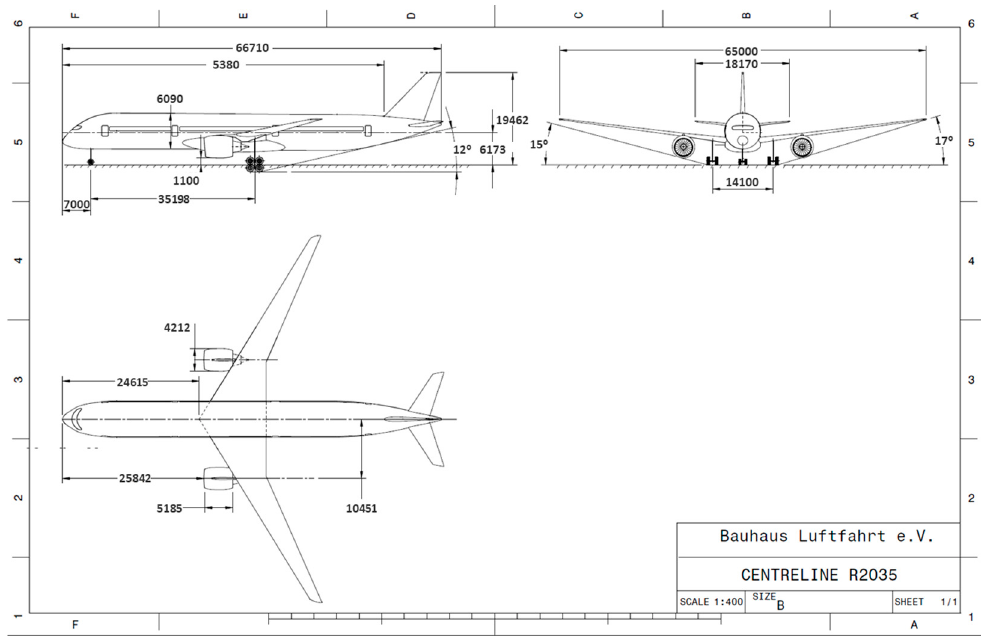
Figure 3. Schematic three-view of the CENTRELINE R2035 baseline aircraft.